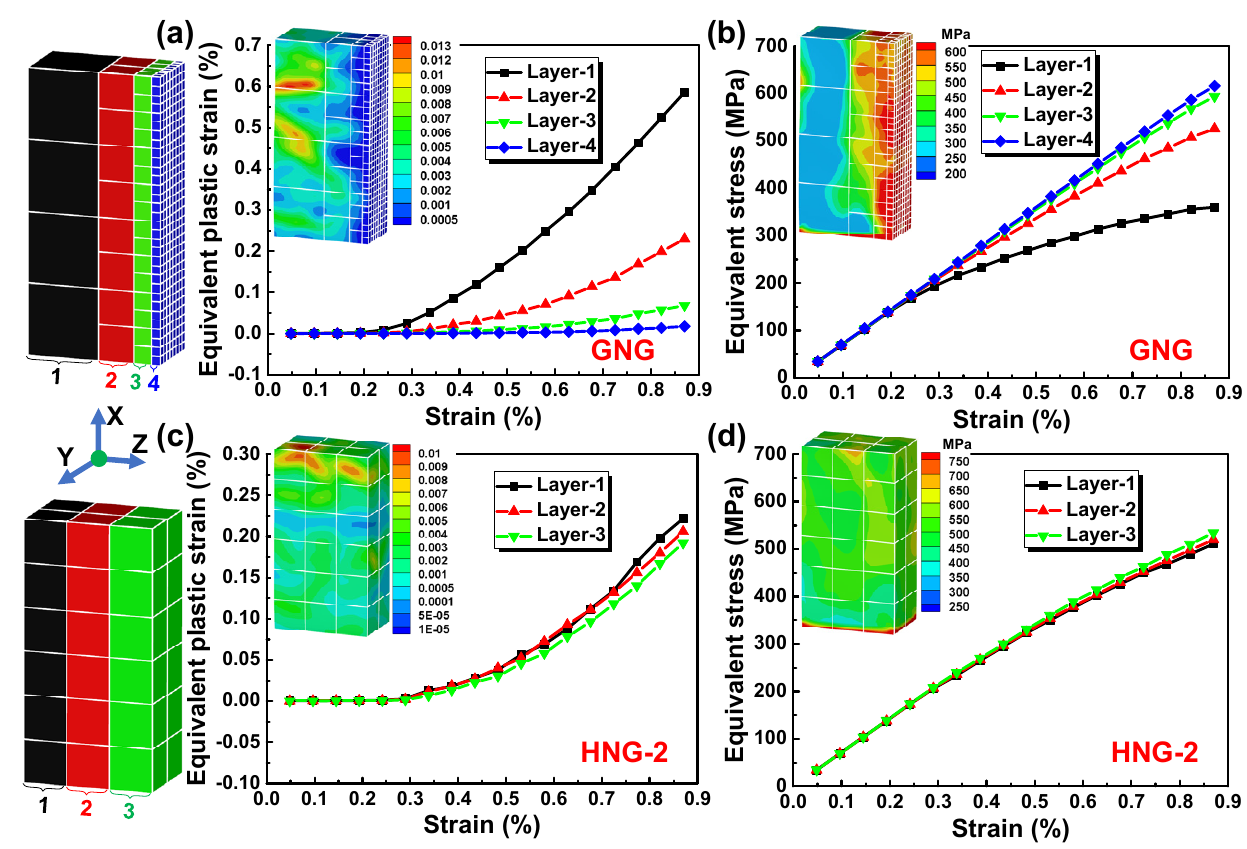
Figure 3. Averaged equivalent plastic strain and equivalent stress versus strain at different layers for ( a , b ) the GNG sample and ( c , d ) the HNG-2 sample. The positions of different layers are indicated in the left figures. Inserts in the plots are corresponding contours of the equivalent plastic strain/stress at the applied strain of ε = 0.87%. The incompatibility in different layers in the GNG sample leads to the gradient dis- tribution of stress and plastic strain, which is believed to be a crucial contributor to the superior strength–ductility synergy for gradient structures [17]. To further understand the nature of this gradient distribution of plastic strain and stress, the evolution of the disloca- tion structure with applied strain is investigated. Figure 4a–f presents the representative dislocation structures at varied strains for the GNG sample. It shows that dislocations start to activate and multiplicate in larger grains and then gradually propagate to smaller grains, resulting in a trend of subsequential yielding of layers with gradient sizes; this is in line with the results presented in Figure 3. With increasing applied strain, more and more dislocations are accumulated in front of grain boundaries. Consequently, dislocation emissions from grain boundaries occur, as indicated by the red lines in Figure